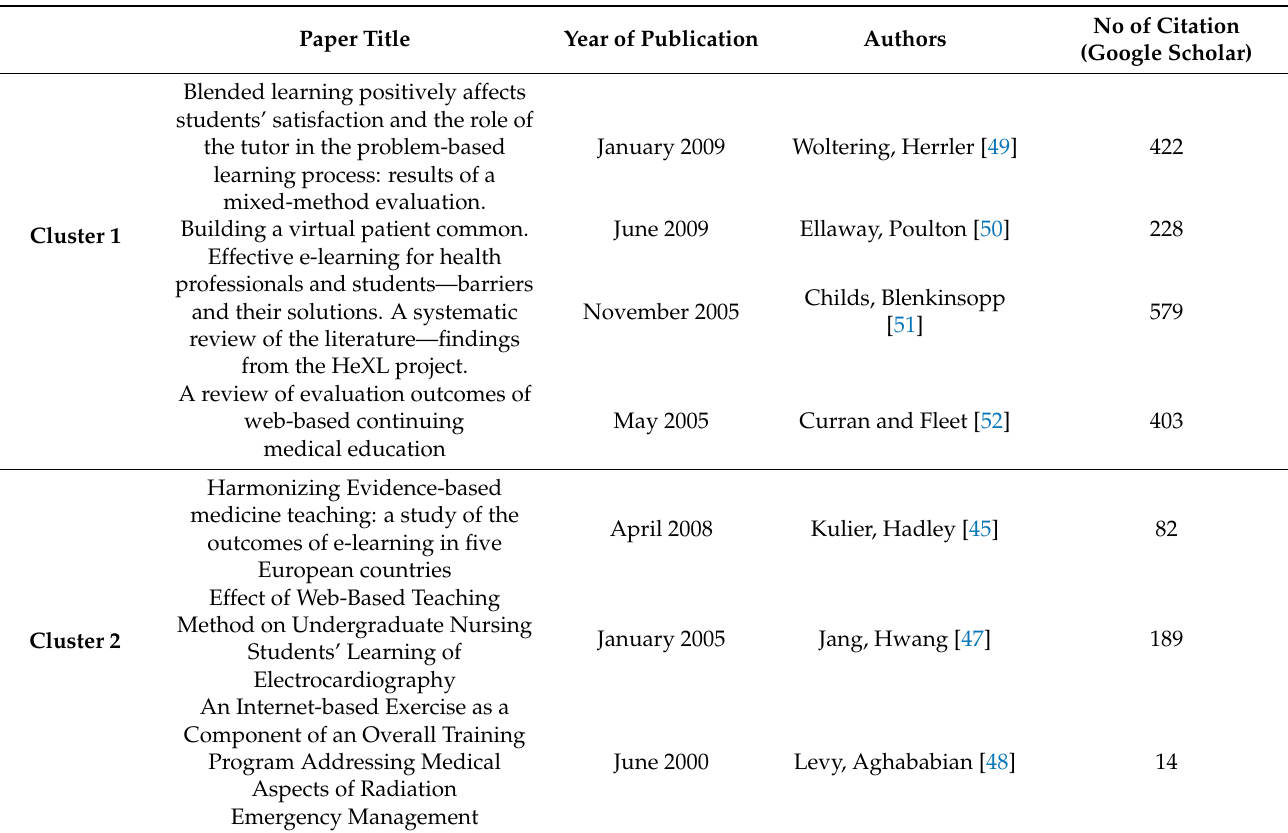
Figure 15. Factorial map of the most cited documents. Table 5. The most cited document by factorial analysis.